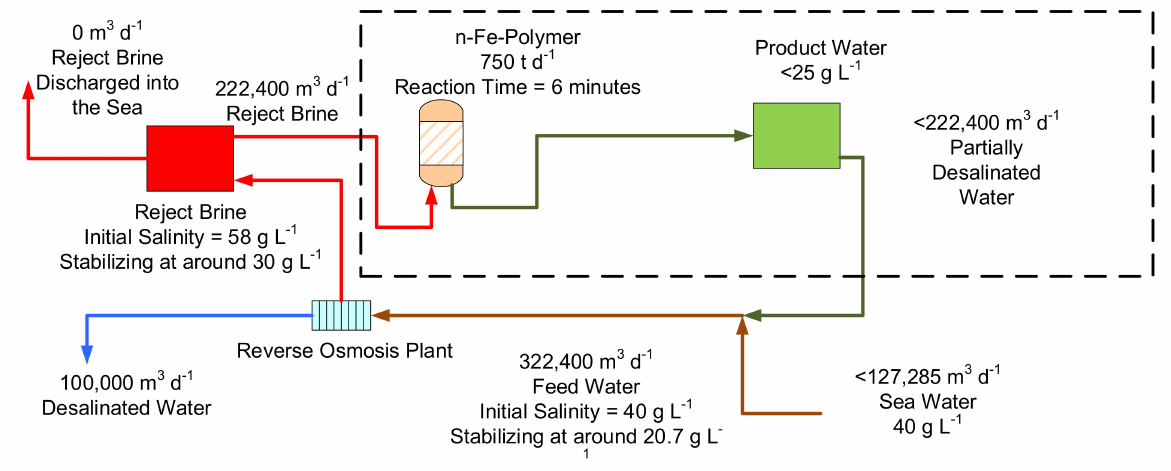
Figure 20. Conceptual design for a zero-waste discharge conventional desalination plant based on 2022 technology, using a recycled n-Fe-polymer to process the reject brine. The required n-Fe-polymer reactor size is around 1000 m 3 . This figure illustrates what might be possible if the experimental results can be transferred into a commercial environment at a future